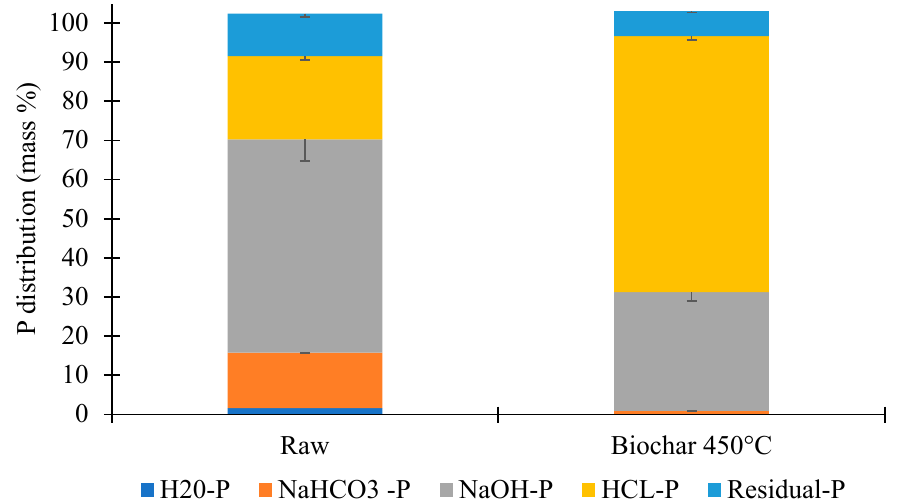
Figure 1. Relative proportions of different P fractions in raw MFS and biochar produced at 450 ◦ C, as determined using the Hedley sequential P extraction method. Colours represent different fractions: H 2 O-P (blue), NaHCO 3 -P (orange), NaOH-P (grey), HCl-P (yellow) and residual-P (purple).